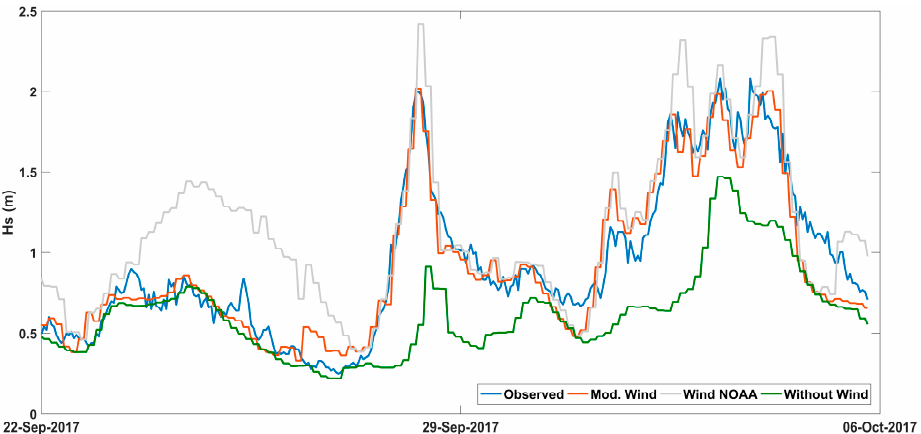
Figure 9. Wave height at ADCP location. The blue line shows the observed data, the green dashed line corresponds to results that do not consider the wind, the grey dashed line represents the data calculated considering the wind, as given by the WWIII model, and the orange dashed line shows the calculated data using the proposed modified wind data.